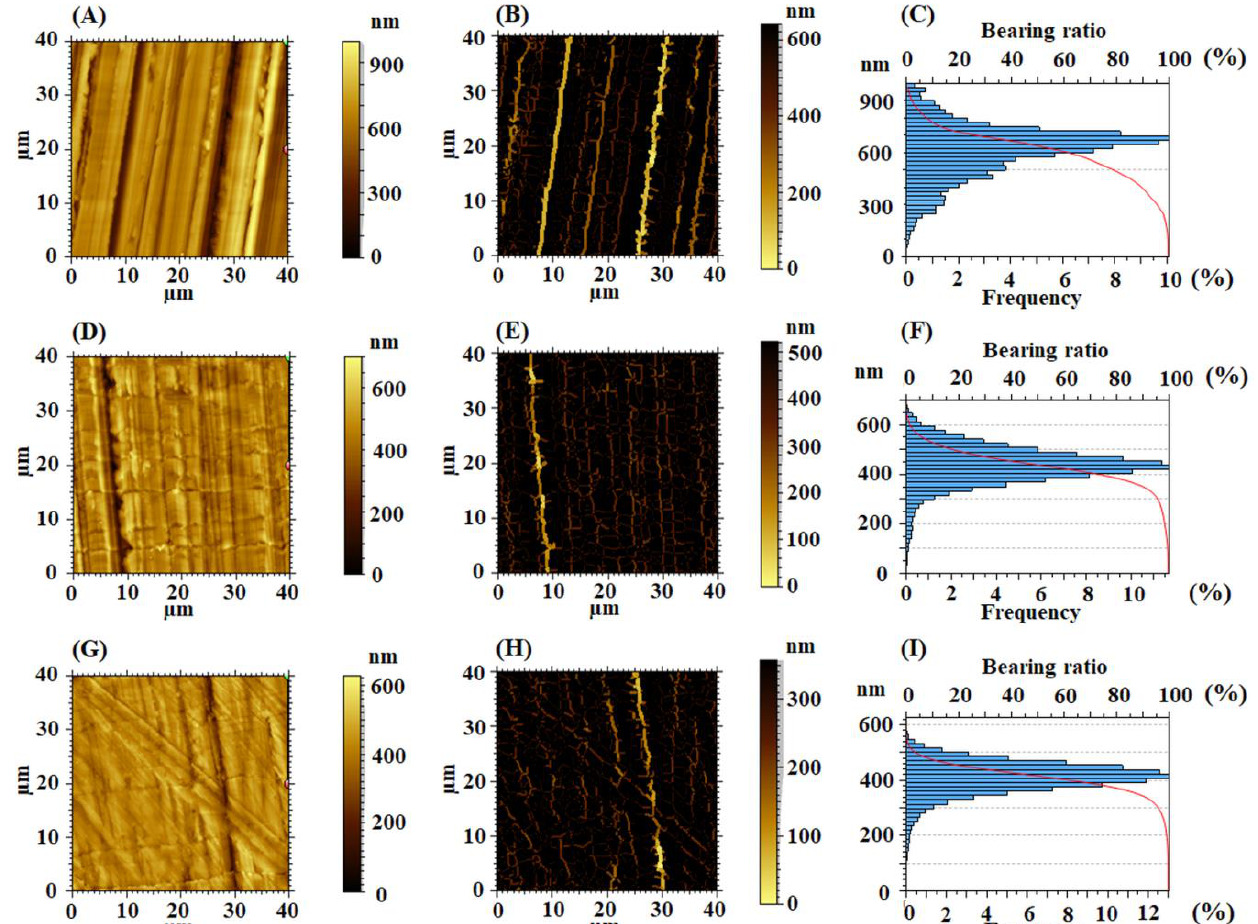
Figure 8. 2D topographical images, furrow maps and histograms/Abbott curves obtained for rubbed